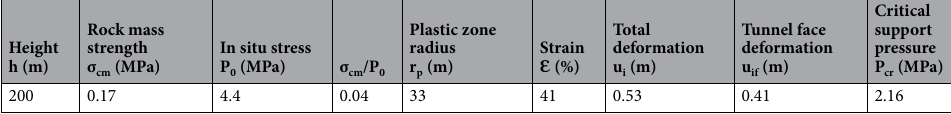
Table 4. Analytical solution results.